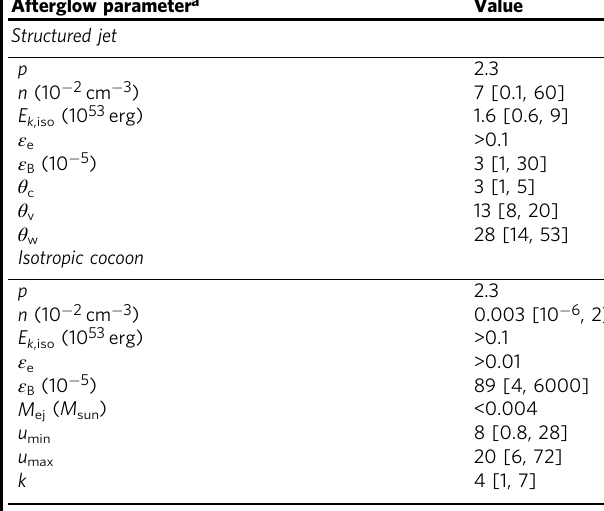
Numbers in parenthesis indicate the 68% uncertainty interval a Our models are characterized by standard afterglow parameters: spectral index p (held fi xed), circumburst density n , isotropic-equivalent blastwave energy E k ,iso , and shock microphysical parameters ε e and ε b . The structured jet model is further de fi ned by the three angular parameters:theGaussianwidthoftheenergydistribution θ c ,theviewingangle θ v ,andthewings truncation angle θ w . The cocoon model is de fi ned by the mass of relativistic ejecta M ej , their maximum u max and minimum u min velocity, and their energy pro fi le with power law slope k